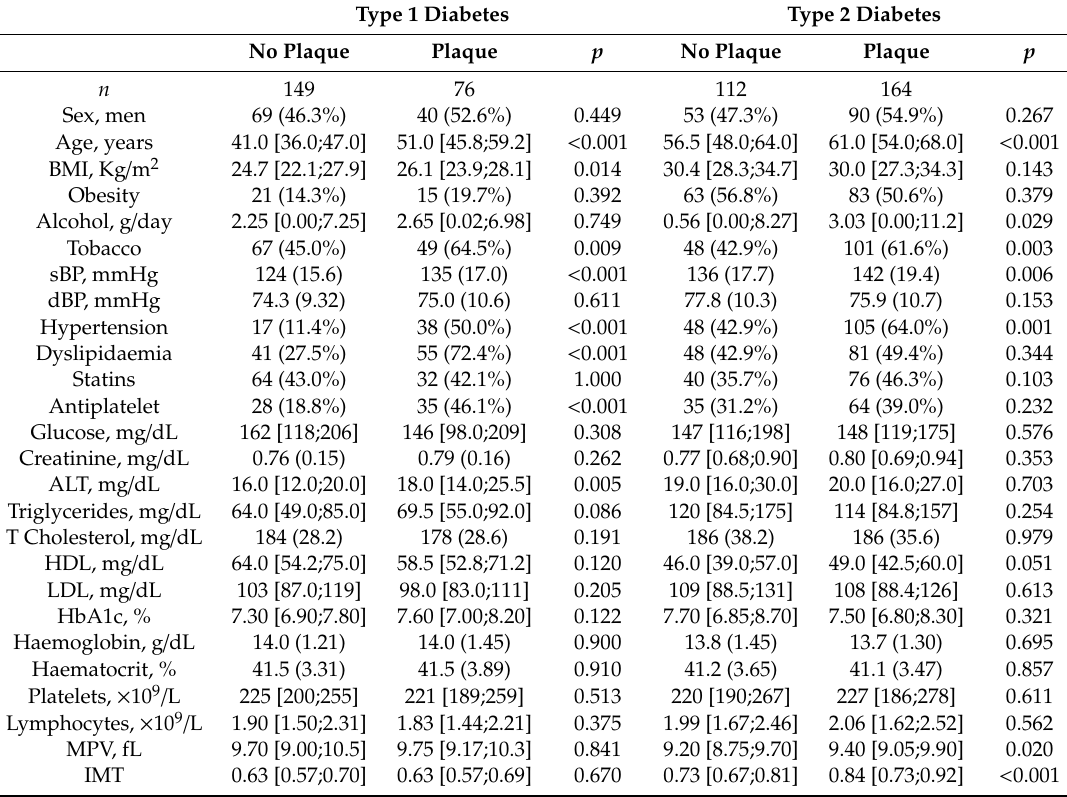
Table 1. Clinical and anthropometrical characteristics of the type 1 and type 2 diabetes groups by the presence or absence of atherosclerotic